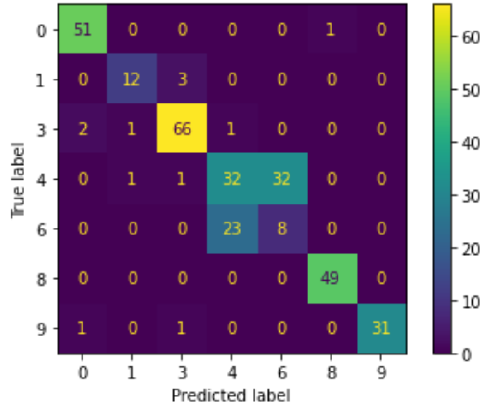
Figure 8. Normalized confusion matrix for object-based RF classification.